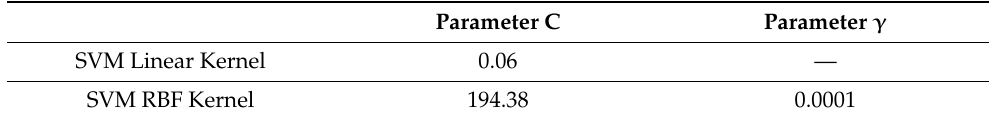
Table 3. Optimal parameters of SVM Models.